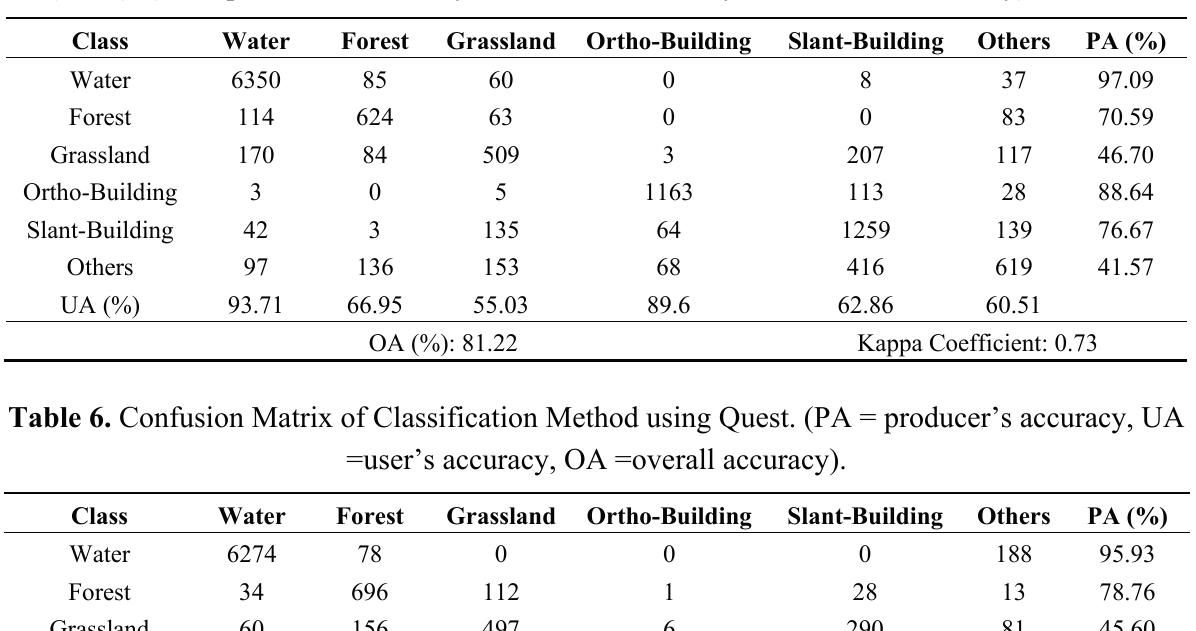
Table 5. Confusion Matrix of Classification Method using Support Vector Machine